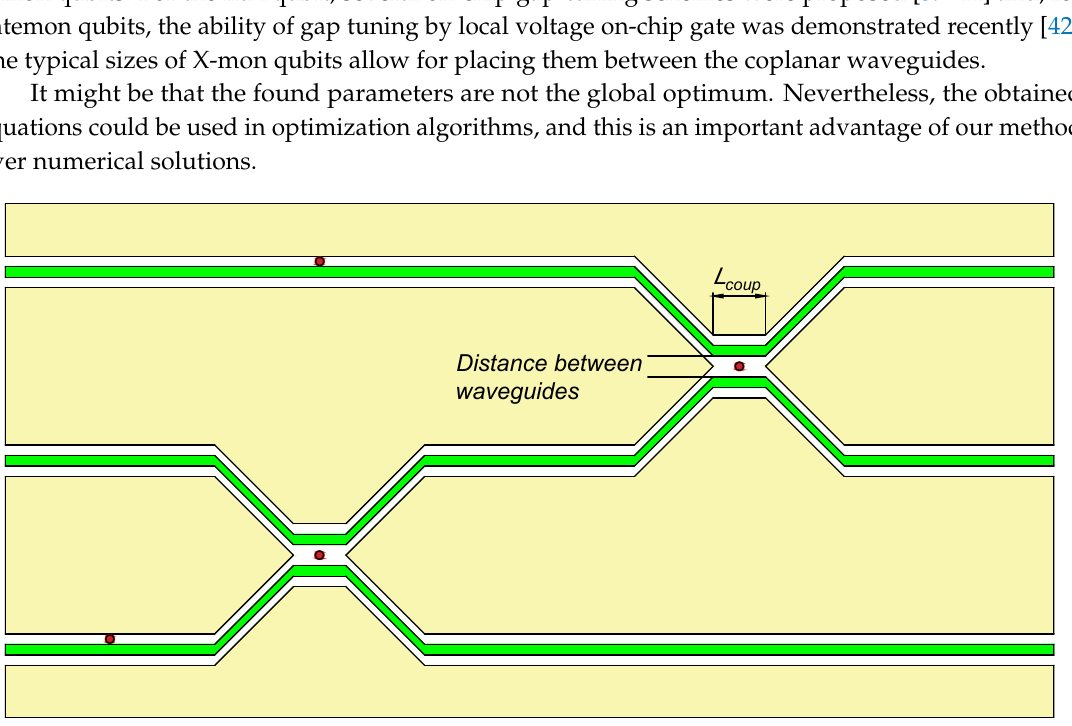
Figure 4. Sketch of the router topology based on a coplanar power divider scheme. Waveguides depicted as green lines, qubits’ positions are red, coplanar ground plates are